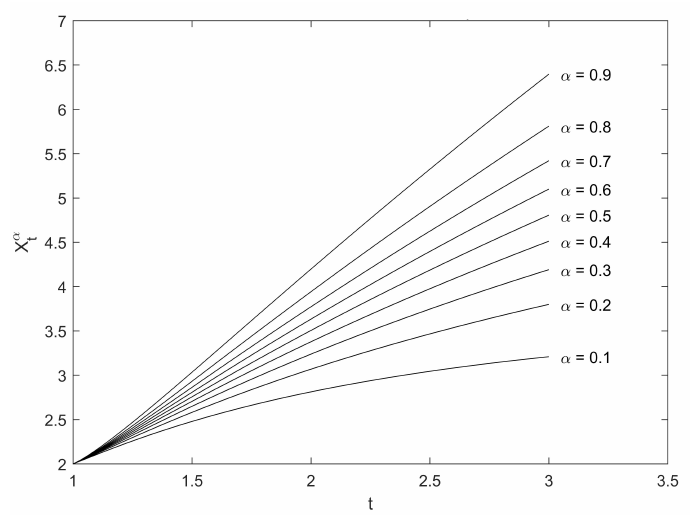
Figure 3. Plots of α -paths of (45) with order p =